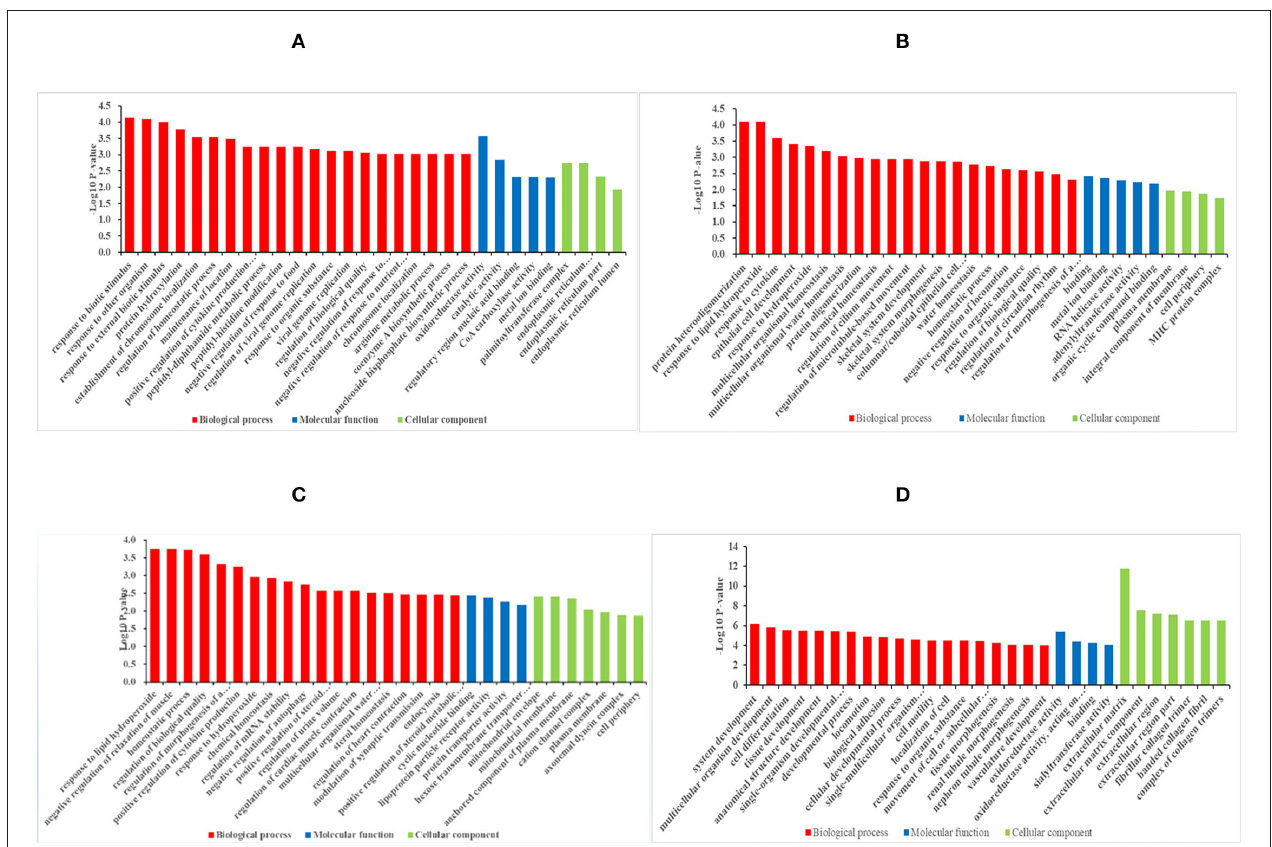
FIGURE 2 | Histogram diagram of DEGs in GO enrichment. (A–D) Histogram diagram of GO enrichment results of DEGs in group of 4 months vs. 1.5 years, 1.5 years vs. 3.5 years, 3.5 years vs. 6 years, and 4 months vs. 6 years,